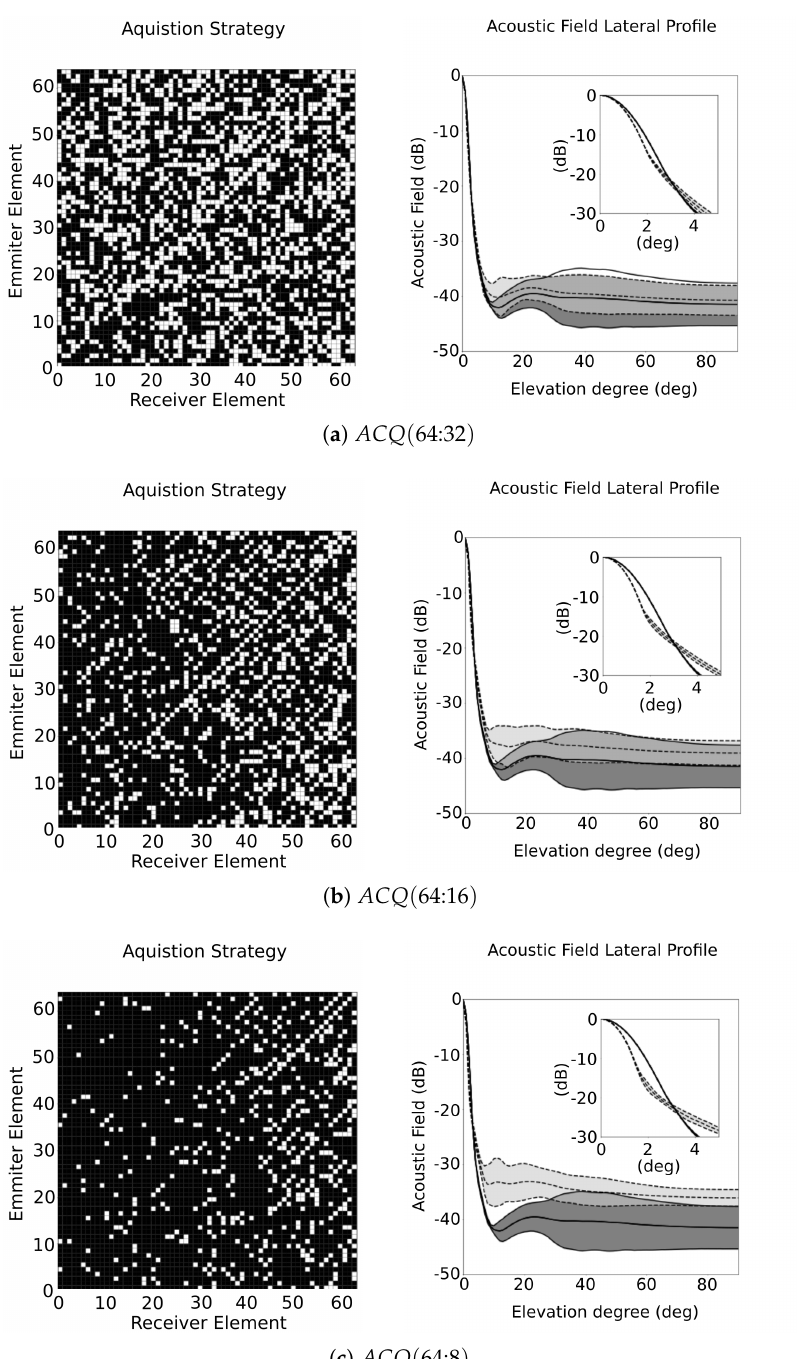
Figure 7. ACQ obtained from the strategy and sidelobes distribution at each elevation angle for strategies ( a ) ACQ ( 64:32 ) , ( b ) ACQ ( 64:16 ) and ( c ) ACQ ( 64:8 ) , where the distribution of the respective ACQ is represented in light grey area within the dashed lines, and the FMC is represented as dark grey area within the